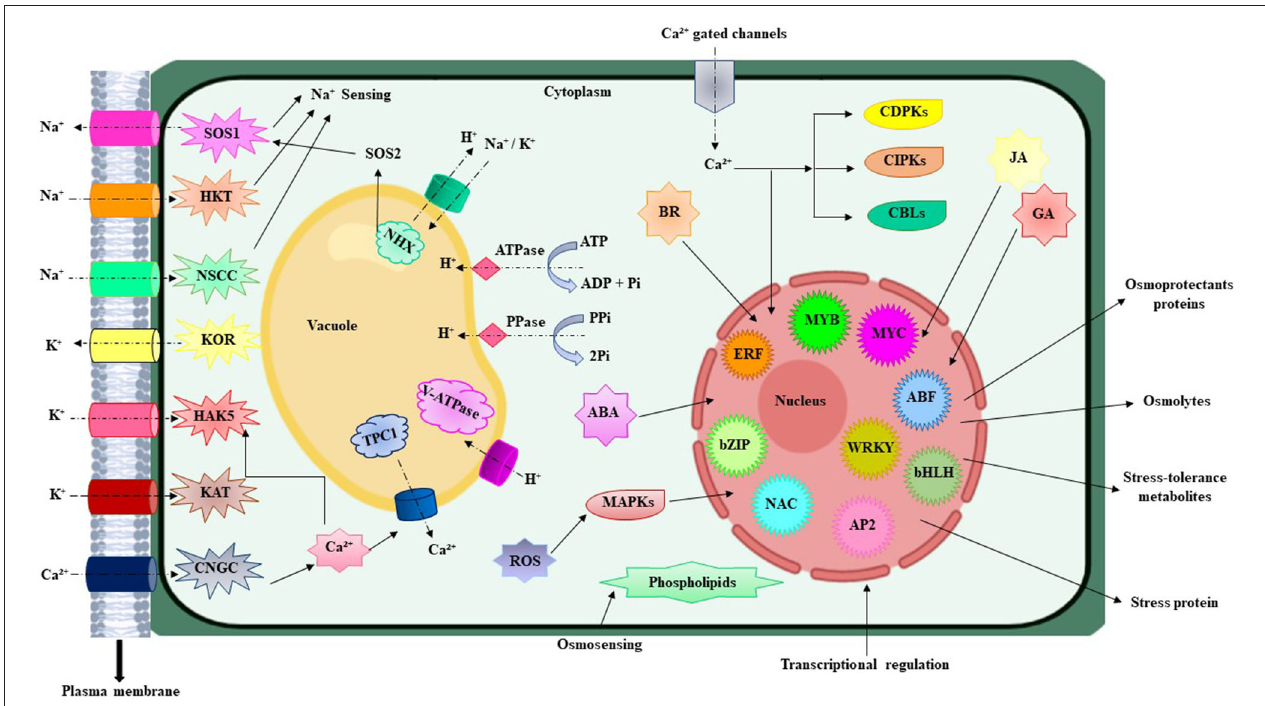
FIGURE 2 | Illustrated the simplified overview of different component for salt response and salt tolerance mechanism in plants. Na + cross the plasma membrane through CNGC, HKT, NSCCs, and some other unknown gated channels (showed as dotted black arrows). This ion imbalance causes the modification in membrane voltage flux and disturbs the inflow and outflow of Ca 2 + and K + ion. After the Na + import into the cell, different unidentified ionic and hyperosmotic sensory networks initiate the early sensing. This resulted in the activation of certain Ca 2 + gate channels and triggered the detoxification pathways via HKT, KOR, KAT, HAKS, and antiporter SOS1 and maintains the ion balance within the cell. SOS1 moves out the Na + from the root cortex while HKTI allows the reverse flux and discharge Na + from xylem to stop the hyperaccumulation in photosynthetic cells. The ionic stress is also tackled via sequestration by means of NHX channels that import the K + or Na + and moves out the H + from the vacuole. H + ions are also transported by the V-ATPase, PPase, and ATPase in opposite direction. Ca 2 + export from the vacuole through TPC1 and helps to maintain the ionic and osmotic balance. At the next step, Ca 2 + produces ROS that showed a positive correlation between them. This activated the signaling pathways of CDPKs, CIPKs, and CBLs which after entry imitates the transcriptional modification. The expression of several gene families is controlled at transcriptional level including MYB, MYC, ERF, bZIP, NAC, WRKY, ABF, AP2, and bHLH change which ultimately provide salt stress tolerance to plants. Also, ABA-mediated pathways triggered the production of JA, BR, and GA that helps the plant to recover from the salinity syndrome. NSCCs, non-selective cation channels; SOS, salt overly sensitive; HKT, high-affinity potassium transporter; KOR, potassium outward-rectifying; HAKs, high-affinity K + transporters; CNGC, cyclic nucleotide-gated ion channel; NHX, sodium hydrogen exchanger; TPC1, two-pore Channel 1; ROS, reactive oxygen species; MAPKS, mitogen activated protein kinases; CIPKs, CBL-interacting protein kinases; CBLs, calcineurin Blike proteins; CDPKs, calcium-dependent protein kinases; bZIP, basic leucine zipper; AP2/ERF, Apetala2/ethylene response factor; JA, jasmonic acid; BR, Brassinosteroids; GA, Gibberellic acid. Signs: Ion transport (dotted arrow), promotion